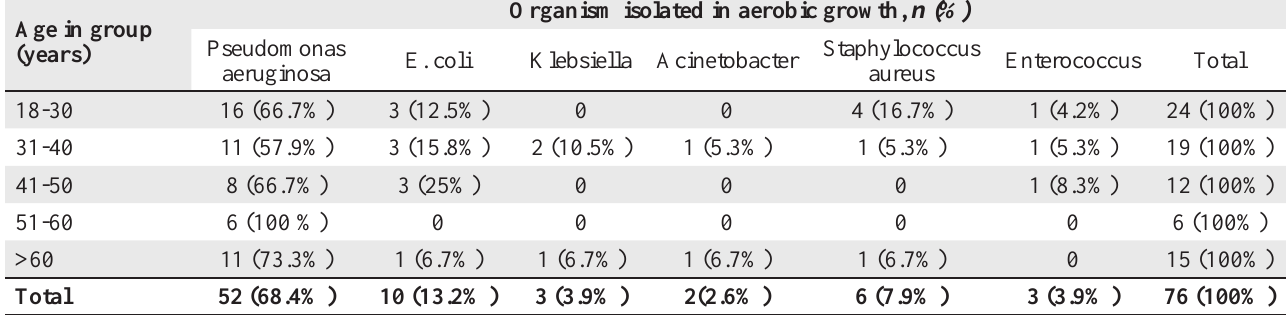
Table 1 : Age wise distribution of common bacterial isolates on culture and sensitivity of bile Age in group